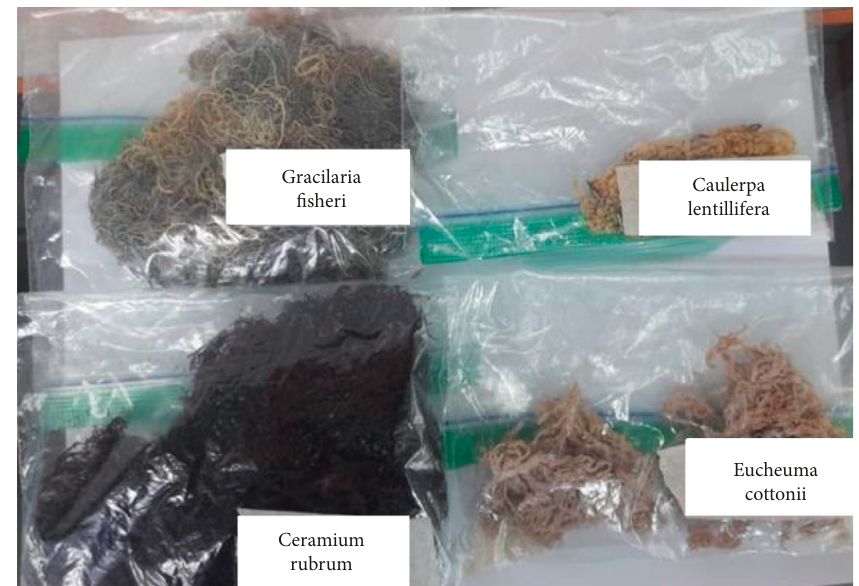
Figure 1: Samples of dried seaweed.